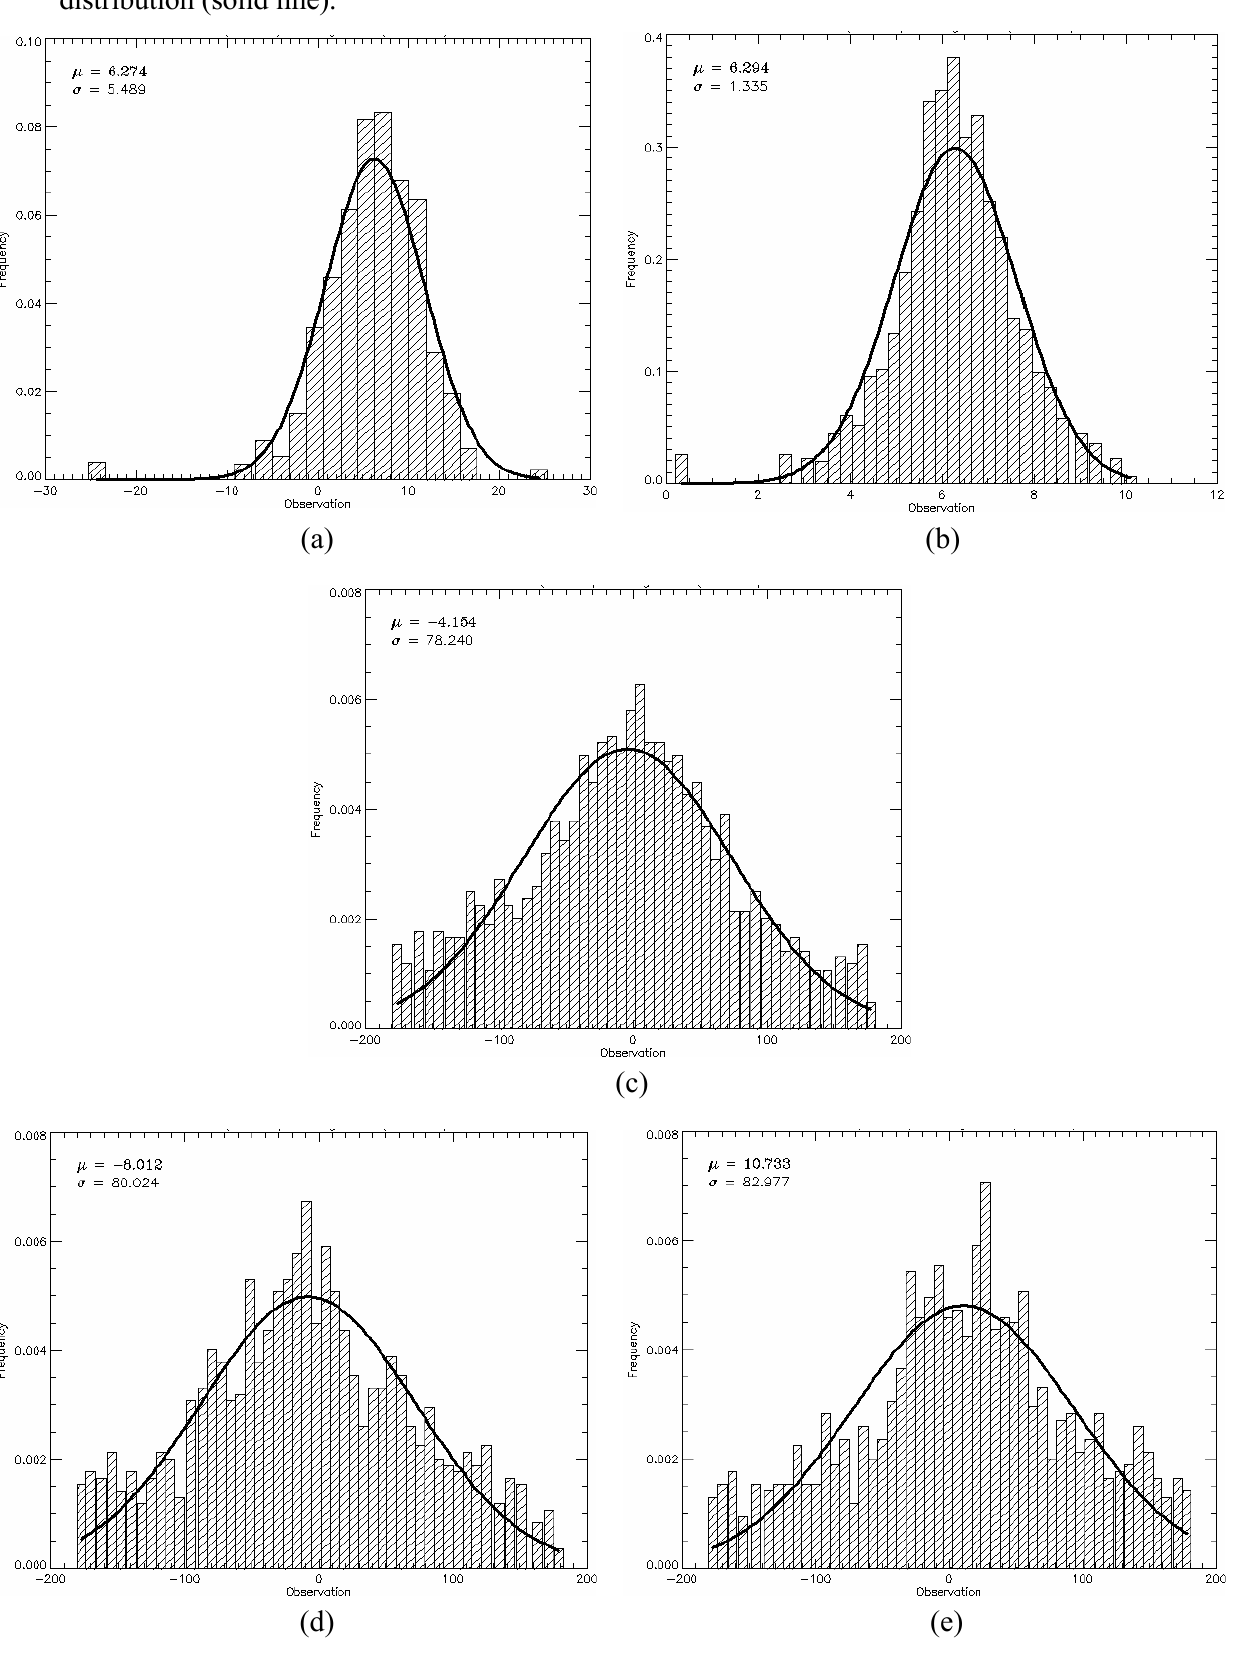
Figure 20. X-band PPD ’s histogram for all regions in comparison to theoretical Gaussian distribution (solid